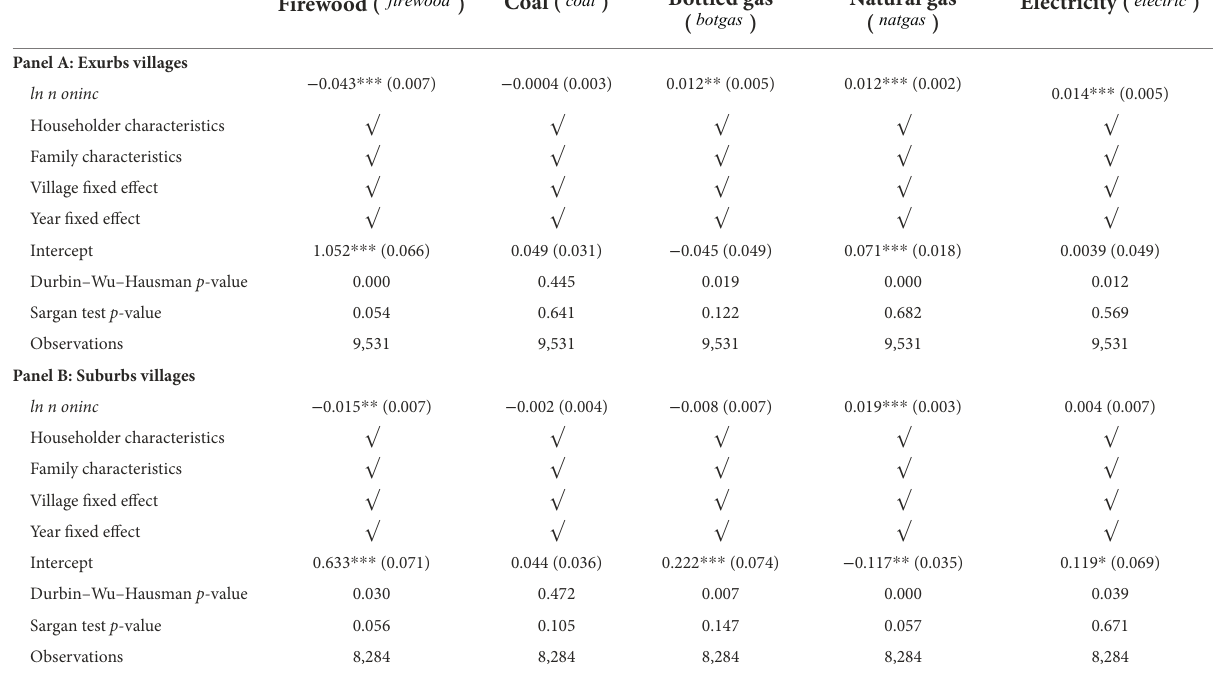
TABLE 10 Heterogeneity test: Estimated by geographical location.